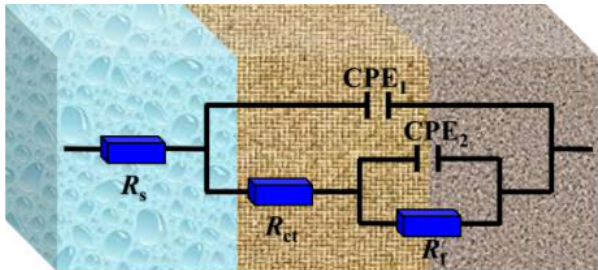
Figure 4. Equivalent circuit used to fit the impedance spectra.